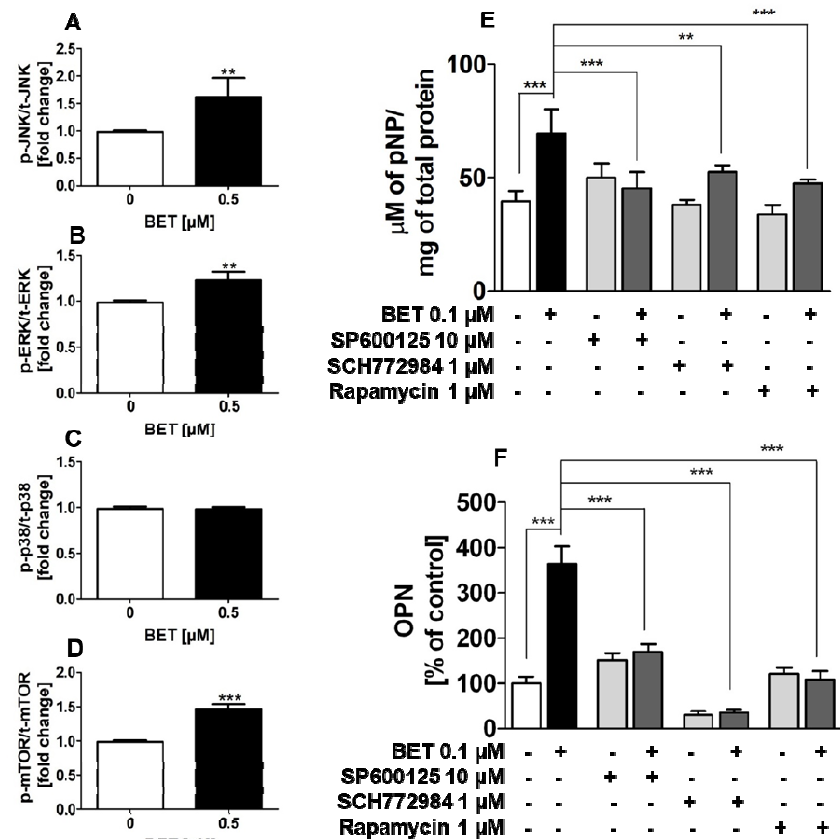
Figure 5. E ff ect of BET on the activation of JNK, ERK1 / 2, p38, and mTOR kinases in the hFOB 1.19 cells ( A – D ). E ff ects of JNK, ERK, and mTOR inhibitors on the levels of BET-induced ALP ( E ) and OPN ( F ). The cells were cultured in an osteoinductive medium with BET at a concentration of 0.5 µ M or without the compound (control) for 6 h (JNK, ERK1 / 2, p38) or 24 h (mTOR). The levels of JNK ( A ), ERK1 / 2 ( B ), p38 ( C ), and mTOR ( D ) phosphorylation in the hFOB1.19 cells were evaluated with the ELISA method. The hFOB 1.19 cells were cultured in an osteoinductive medium with BET at a concentration of 0.1 µ M or co-treated with SP600125 (5 µ M), rapamycin (1 µ M), or SCH772984 (1 µ M). The osteoinductive medium supplemented with BET or BET plus the inhibitor was changed every three days. ALP activity was evaluated after 6 days with the colorimetric method with pNPP as a substrate for ALP. The OPN levels were measured after 9 days with the ELISA method. Mean ± SD from three independent experiments; ** p < 0.01, *** p < 0.001 in comparison to the control, one-way ANOVA with post hoc Dunnett’s test ( A – D ) and Tukey’s test ( E and F ).